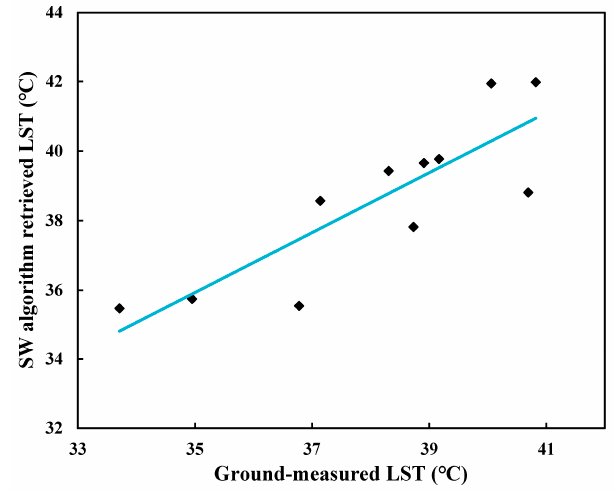
Figure 15. SW algorithm-retrieved LST (°C) compared with ground-measured data.